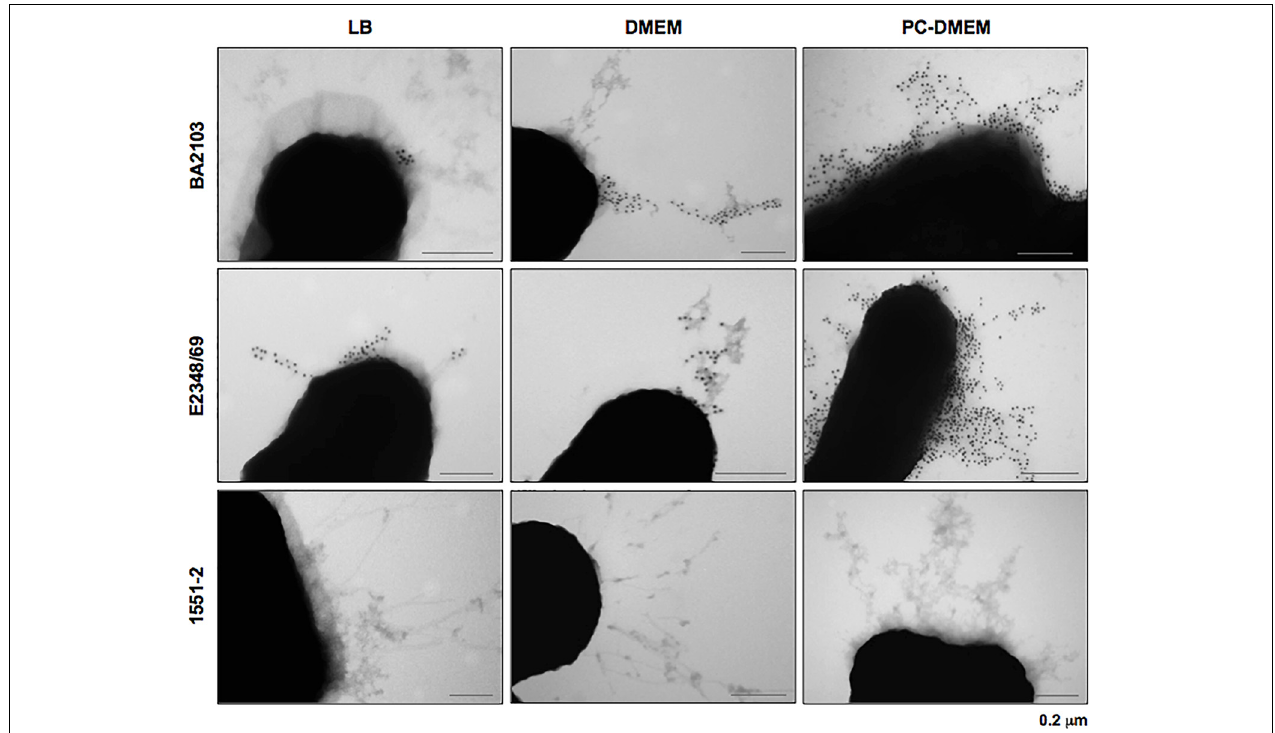
FIGURE 3 | Growth medium-dependent production of ECP visualized by TEM. aEPEC strain BA2103 grown in PC-DMEM, DMEM and LB was reacted with rabbit anti-EcpA antibody and goat anti-rabbit IgG antibody conjugated with 10 nm colloidal gold particles. E2348/69 and 1551-2 were used as positive and negative controls of ECP production, respectively. Bars: 0.2 µ